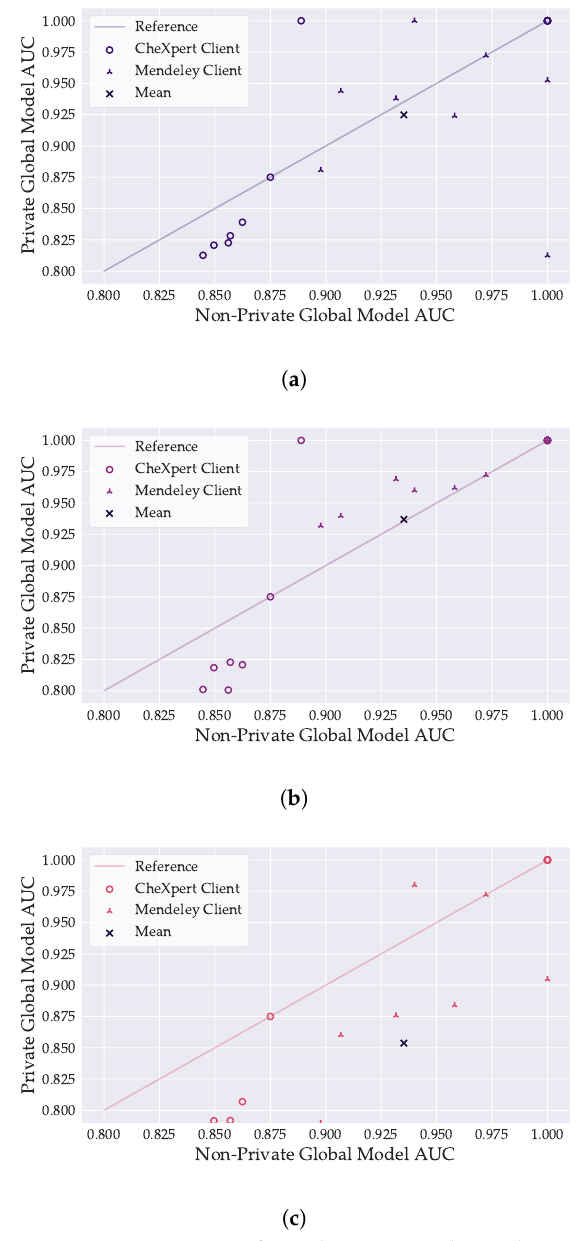
Figure A2. Comparison of per-client AUC values achieved by the best global DenseNet121 models between non-private and private training with ( a ) ε = 10, ( b ) ε = 6, ( c ) ε = 3. The bottom left circle markers belong to CheXpert clients with large datasets. Privacy demanded a higher cost in model accuracy on CheXpert clients. The figures do not consider AUC values below 0.79. Markers may